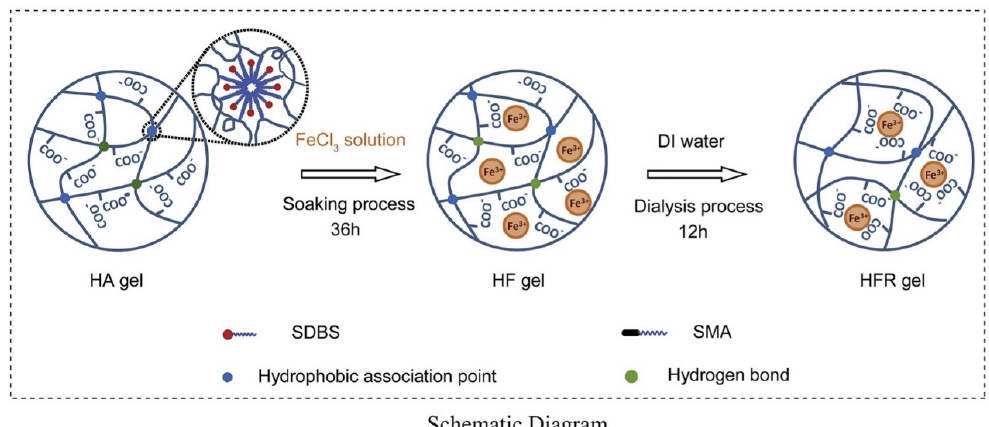
Figure 11. Synthesis mechanism of dual physically crosslinked gels based on hydrophobic associ- ations and electrostatic interactions between iron ions. (Reprinted/adapted with permission from Ref. [66], 2018, Hu et al.).